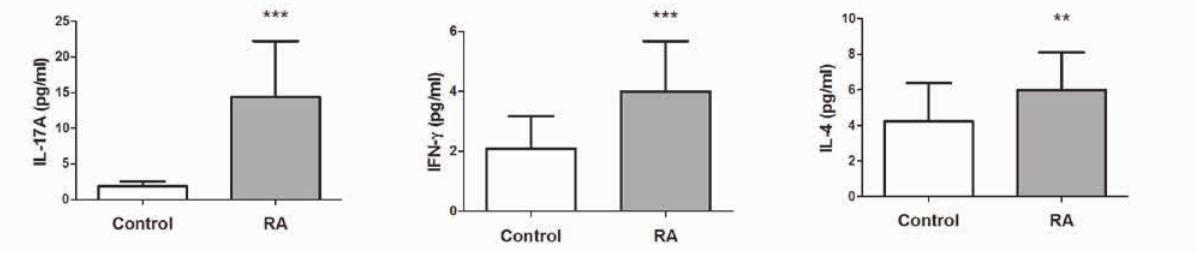
Figure 1. Serum levels of IL-17A, IL-4 and INFγ in patients with early RA and healthy